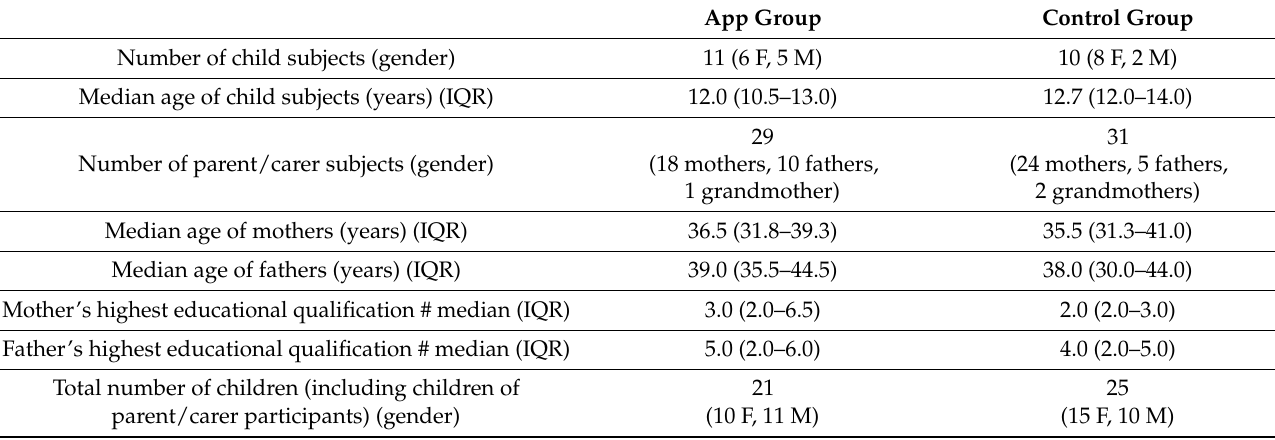
Table 1. Characteristics of